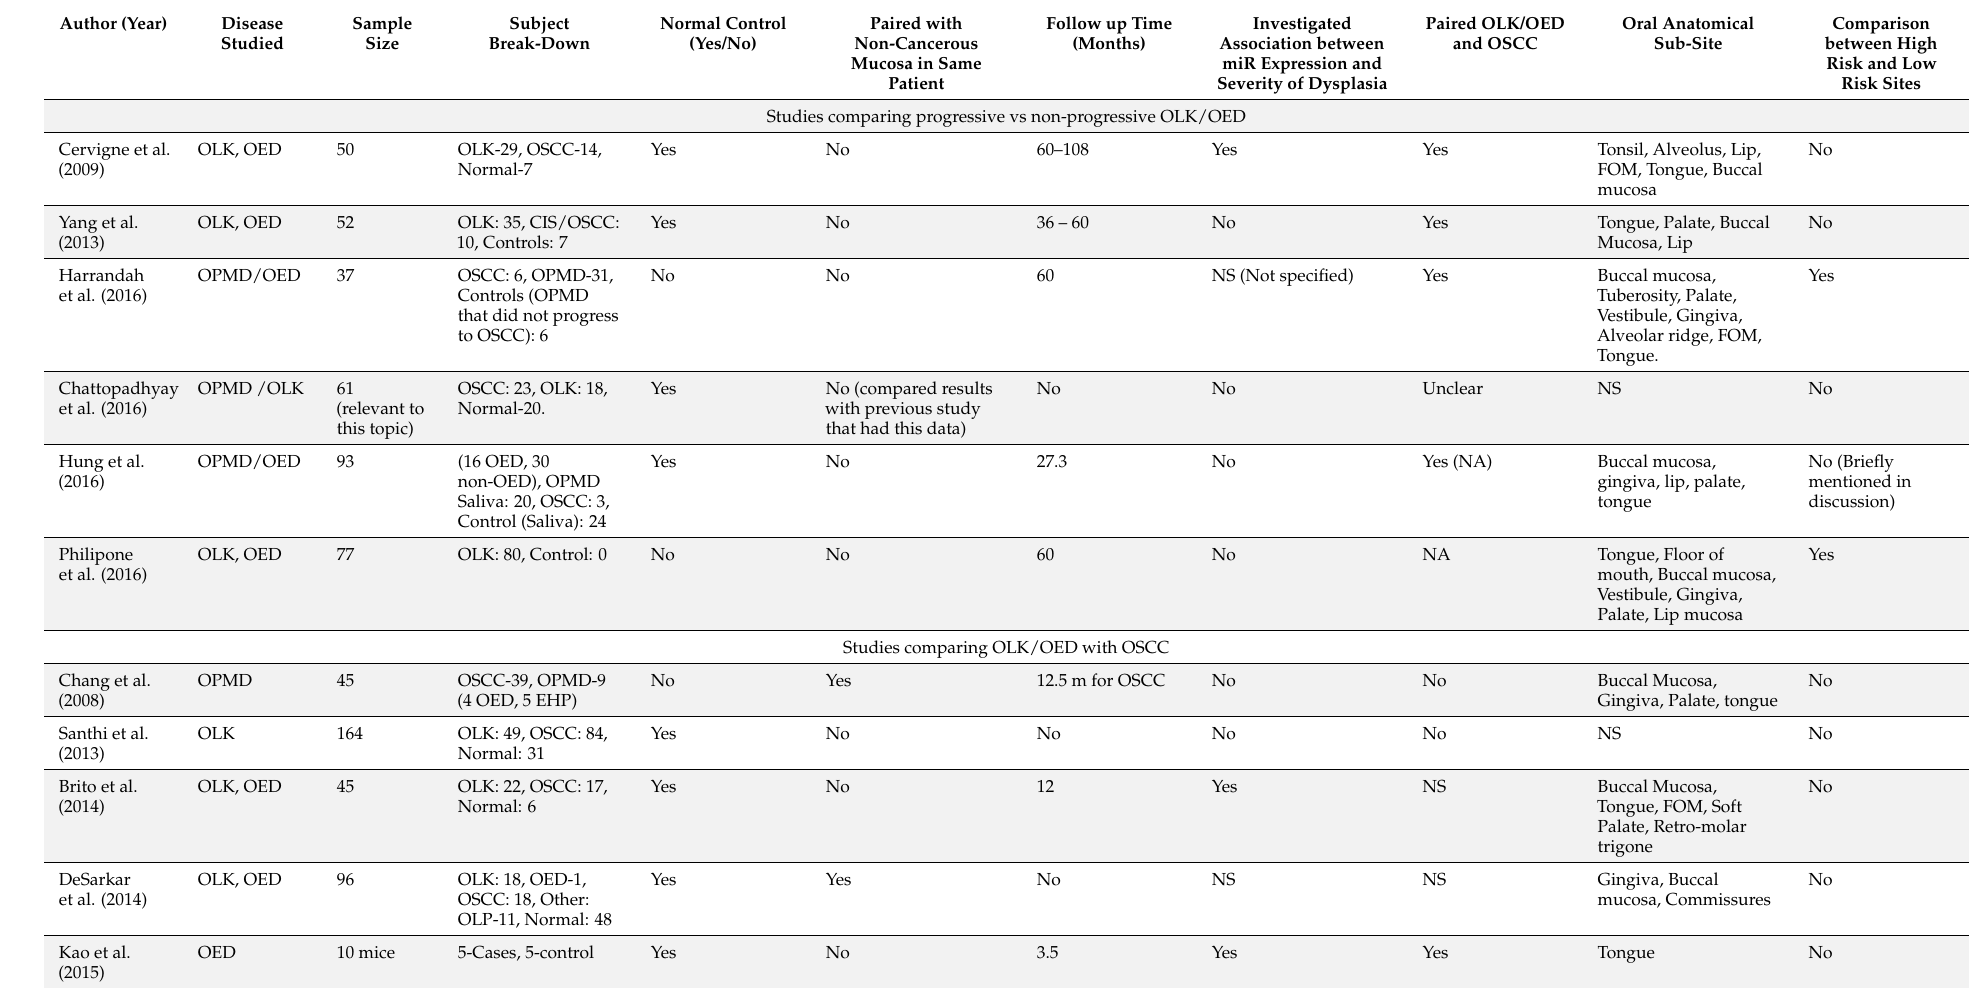
Table 2. Study characteristics and key features of included